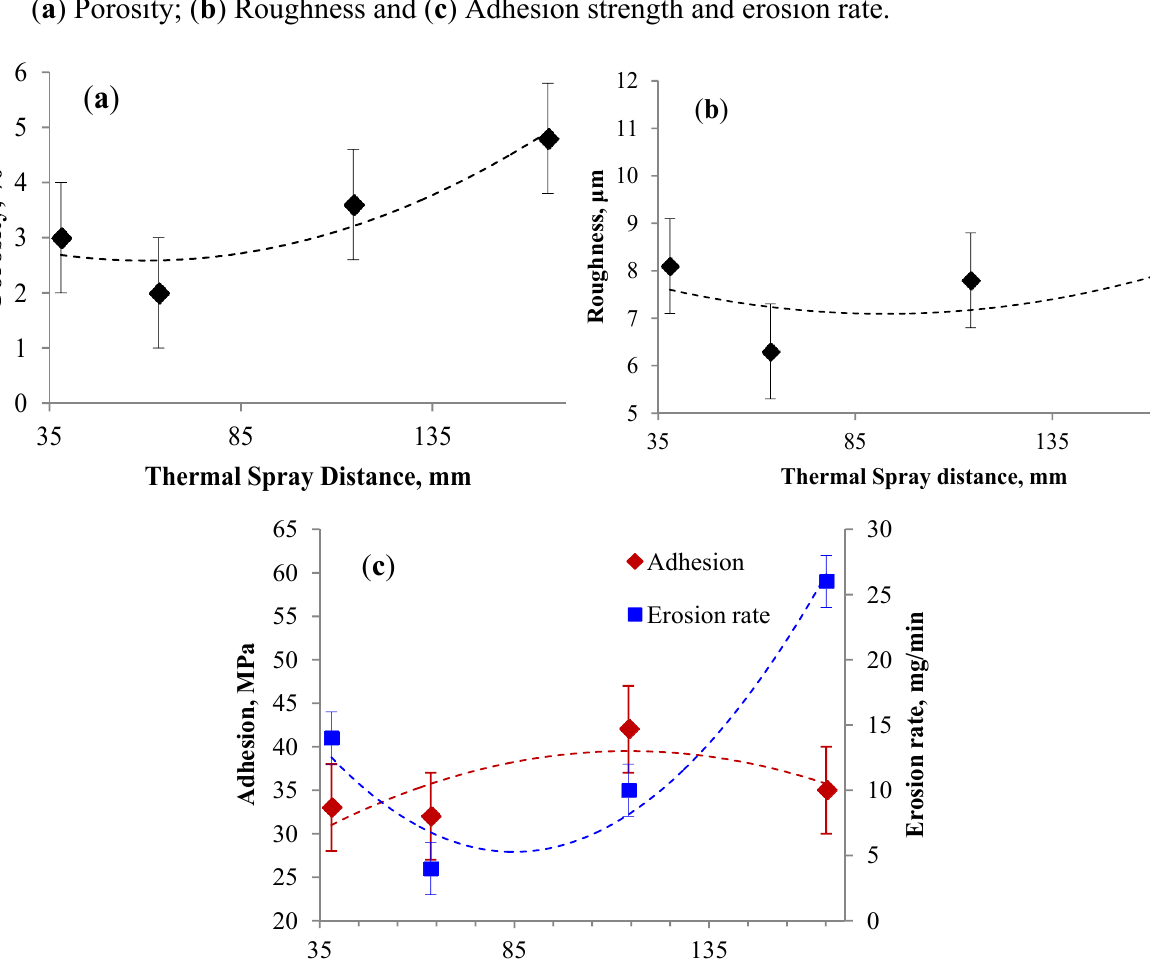
Figure 7. Dependence of the properties of Ni-Al coatings on thermal spray distance: ( a ) Porosity; ( b ) Roughness and ( c ) Adhesion strength and erosion